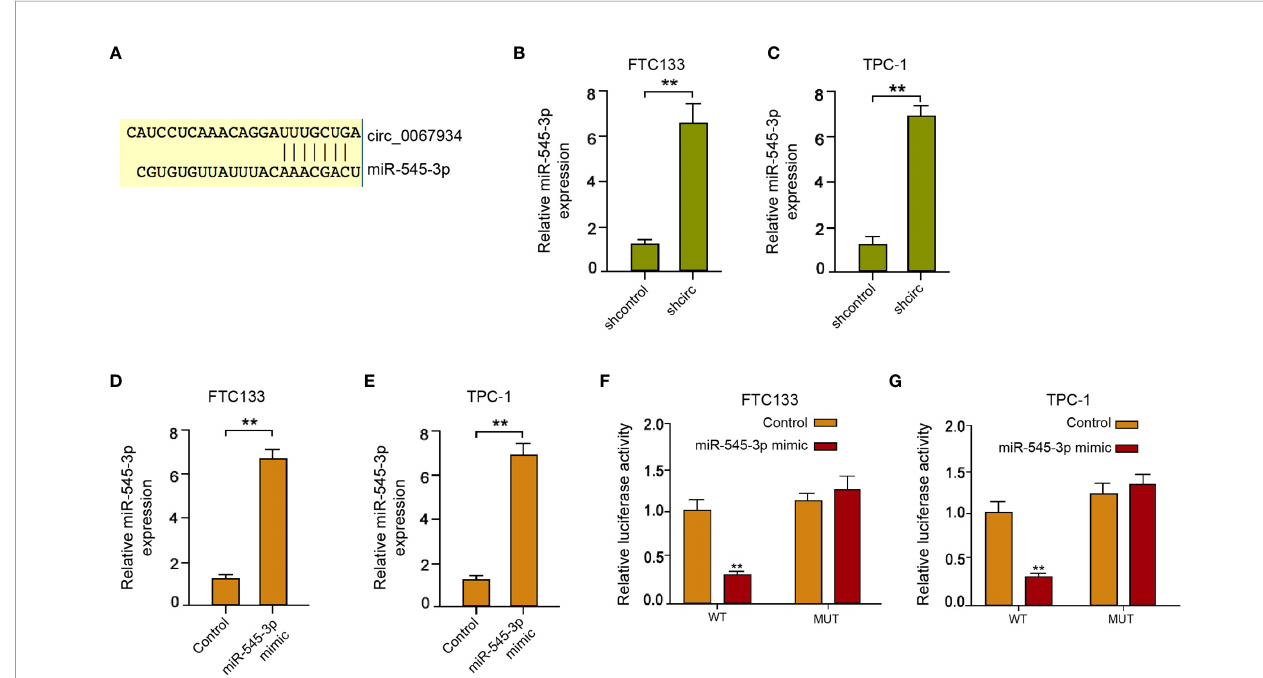
FIGURE 3 | Circ_0067934 conversely modulates miR-545-3p. (A) The binding sites of circ_0067934 and miR-545-3p. (B, C) The measurement of miR-545-3p expression in FTC133 and TPC-1 cells by RT-qPCR. (D – G) The FTC133 and TPC-1 cells were treated with miR-545-3p mimic (100nM). (D, E) The detection of miR-545-3p expression in FTC133 and TPC-1 cells by RT-qPCR. (F, G) Measurement of luciferase activity of circ_0067934 by dual luciferase reporter assays in FTC133 and TPC-1 cells. mean ± SD, ** P <